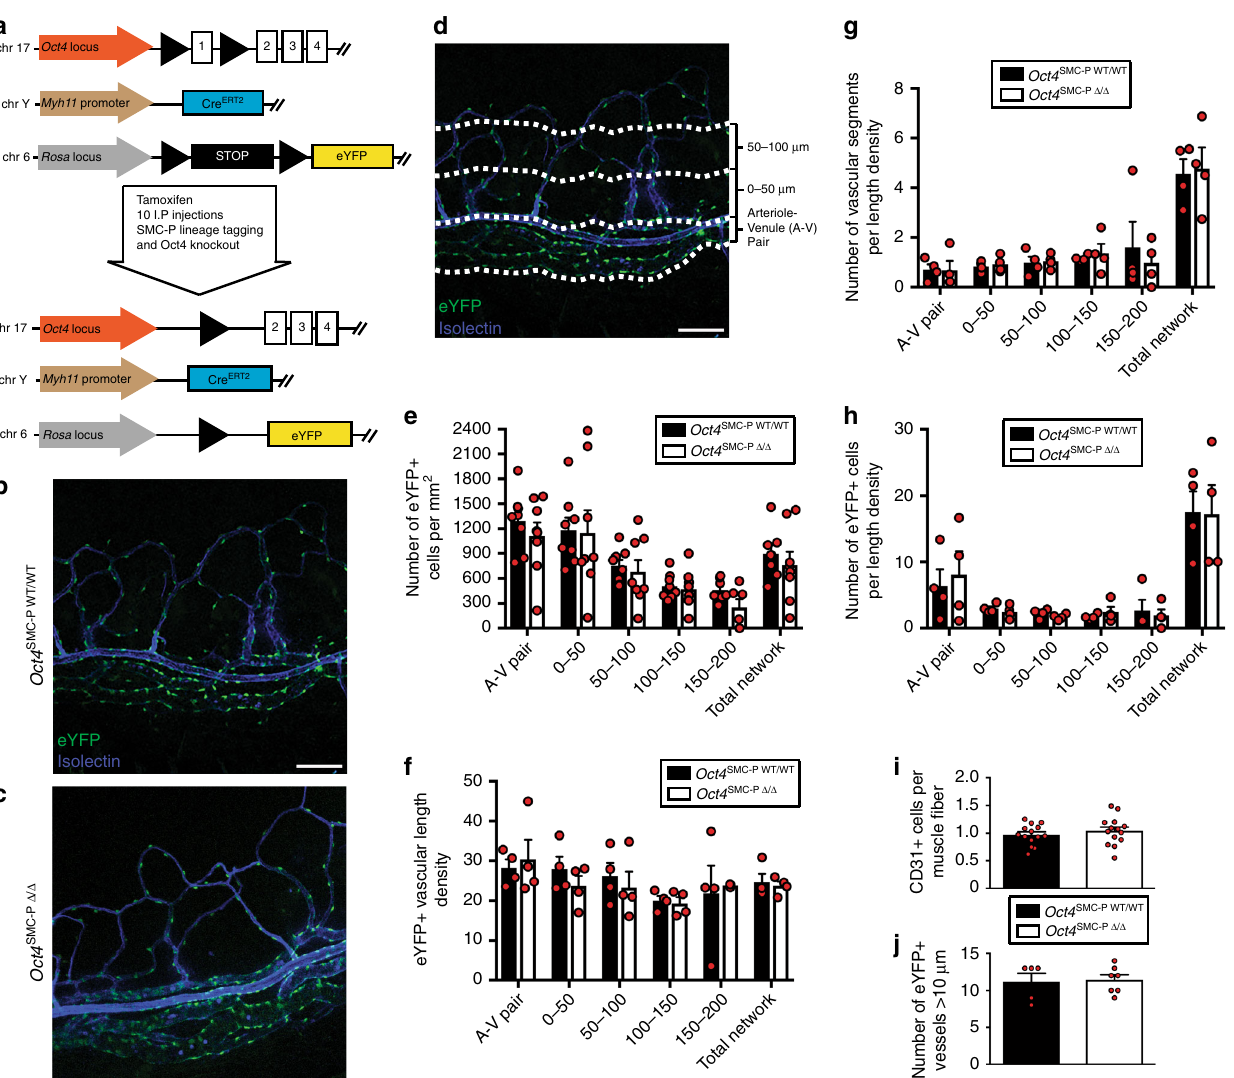
Fig. 2 There were no differences in the corneal or hindlimb vasculature at baseline following SMC-P knockout of Oct4. a Myh11-CreER T2 ROSA fl oxed STOP eYFP Oct4 WT/WT and Myh11-CreER T2 ROSA fl oxed STOP eYFP Oct4 FL/FL male littermate mice were injected with tamoxifen (10 intraperitoneal injections) from 6 to 8 weeks of age to induce simultaneous lineage tagging, without or with Oct4 KO, respectively. For simplicity, we refer to them henceforth as Oct4 SMC-P WT/WT and Oct4 SMC-P Δ / Δ , respectively. b , c Representative intravital confocal images of Oct4 SMC-P WT/WT and Oct4 SMC-P Δ / Δ corneas showing native eYFP (green) and perfused isolectin (blue). Scale bar = 50 μ m. d Prior to injury, there is limbal vasculature consisting of a main arteriole – venule (A – V) pair at the base of the vascular network, as well as vessels extending ~200 μ m away from the A – V pair toward the center of the cornea. To more rigorously quantify number of cells in the limbal vasculature, we divided this region in to 50 μ m regions, where 50 μ m was measured from the edge of the A – V pair towards the center of the cornea along the total width of the montaged image. Scale bar = 50 μ m. e – h Quanti fi cation of eYFP + cell density ( e ), eYFP + vascular length density ( f ), eYFP + vascular segments per length density ( g ), and number of eYFP + cells per length density ( h ) in Oct4 SMC-P WT/WT and Oct4 SMC-P Δ / Δ corneas immediately prior to injury [ n = 8 WT, 8 KO ( e ); n = 4 WT, 4 KO ( f – h )]. i – j Quanti fi cation of the number of CD31 + cells per muscle fi ber ( i ) and number of eYFP + vessels >10 μ m diameter ( j ) in hindlimb muscle of Oct4 SMC-P WT/WT and Oct4 SMC-P Δ / Δ mice [ n = 14 WT, 14 KO ( i ); n = 5 WT, 7 KO ( j )]. Values = mean ± s.e.m. Statistics were performed using two-way ANOVA ( e – h ), unpaired two-tailed t -test ( i ),